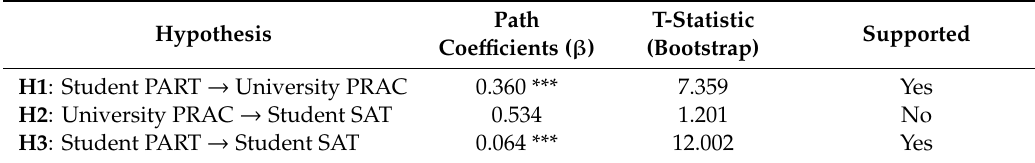
Table 9. Comparison of hypotheses’